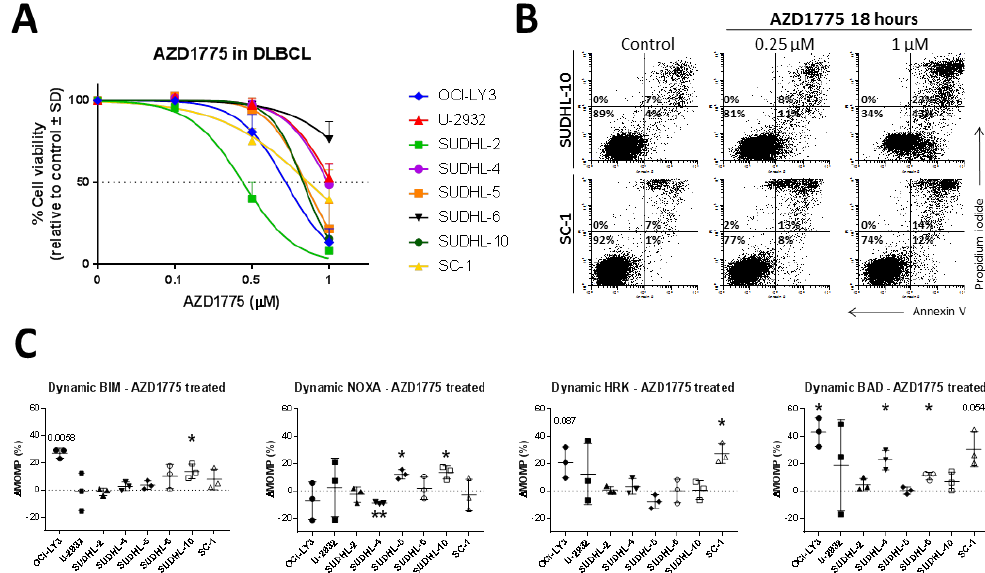
Figure 1. Apoptosis induced by AZD1775 in diffuse large B-cell lymphoma (DLBCL). ( A ) Cell viability analysis was measured with propidium iodide flow cytometry in DLBCL cell lines treated with AZD1775 for 72 h. Data were plotted as the mean ± SD ( n = 3). ( B ) Representative flow cytometry of apoptosis (Annexin V/Propidium iodide) induced by treatment of AZD1775 for 18 h in representative cell lines SUDHL-10 and SC-1. ( C ) Mitochondrial response of DLBCL cell lines treated with AZD1775 for 18 h, plotted as the delta mitochondrial outer membrane permeabilization (ΔMOMP%). ΔMOMP% was calculated by subtracting the percentage treated MOMP from percentage untreated MOMP. Cell line SUDHL-10 was treated with 0.25 µM AZD1775, cell lines OCI-LY3, U-2932, SUDHL-2, and SUDHL-5 were treated with 0.5 µ M AZD1775 and cell lines SUDHL-4, SUDHL-6, and SC-1 were treated with 1 µ M AZD1775. Data were plotted as the mean ± SD ( n = 3). Statistical analysis was performed using